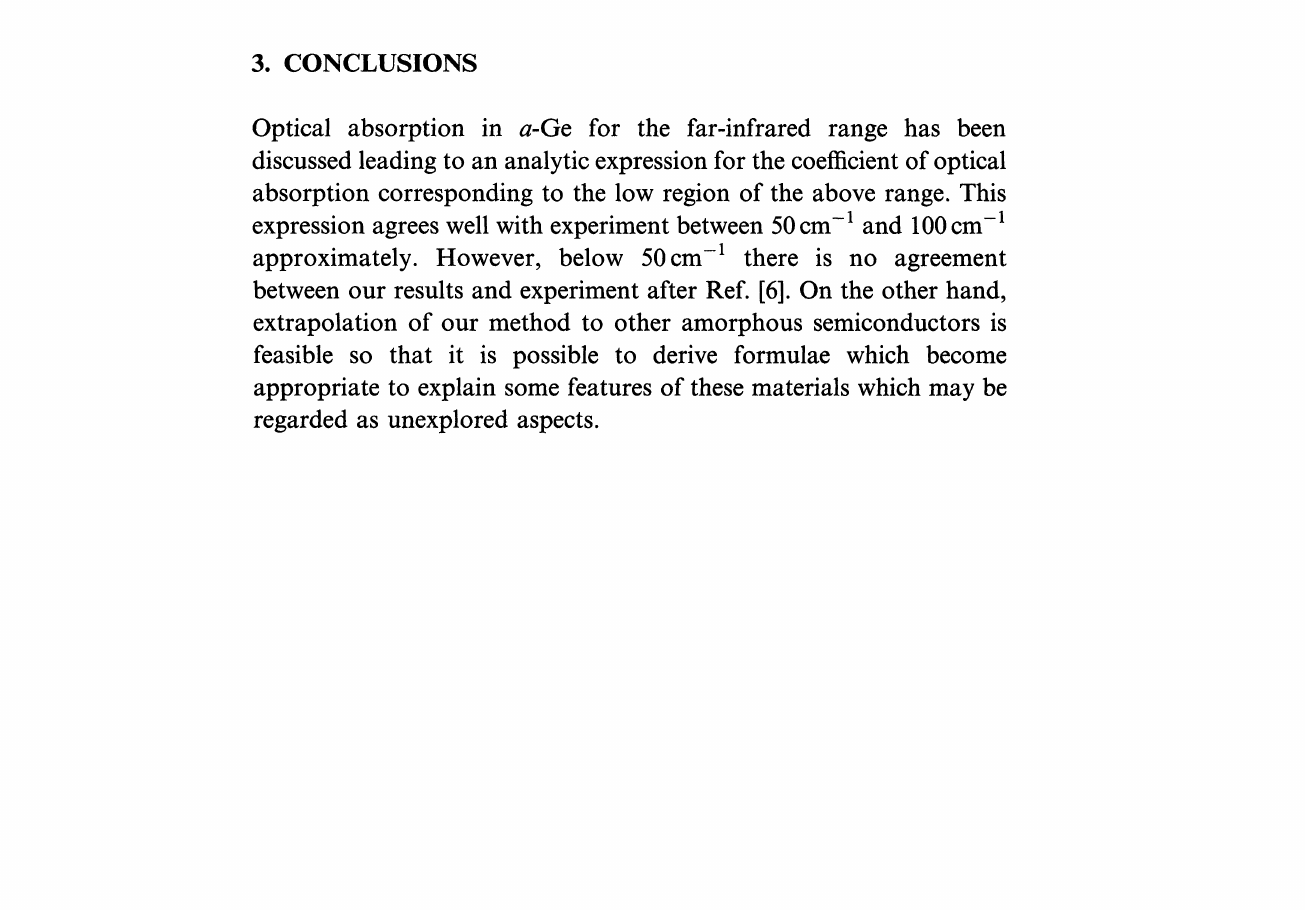
FIGURE Optical absorption coefficient of a-Ge; this plot is experimental (after Ref. [6]).